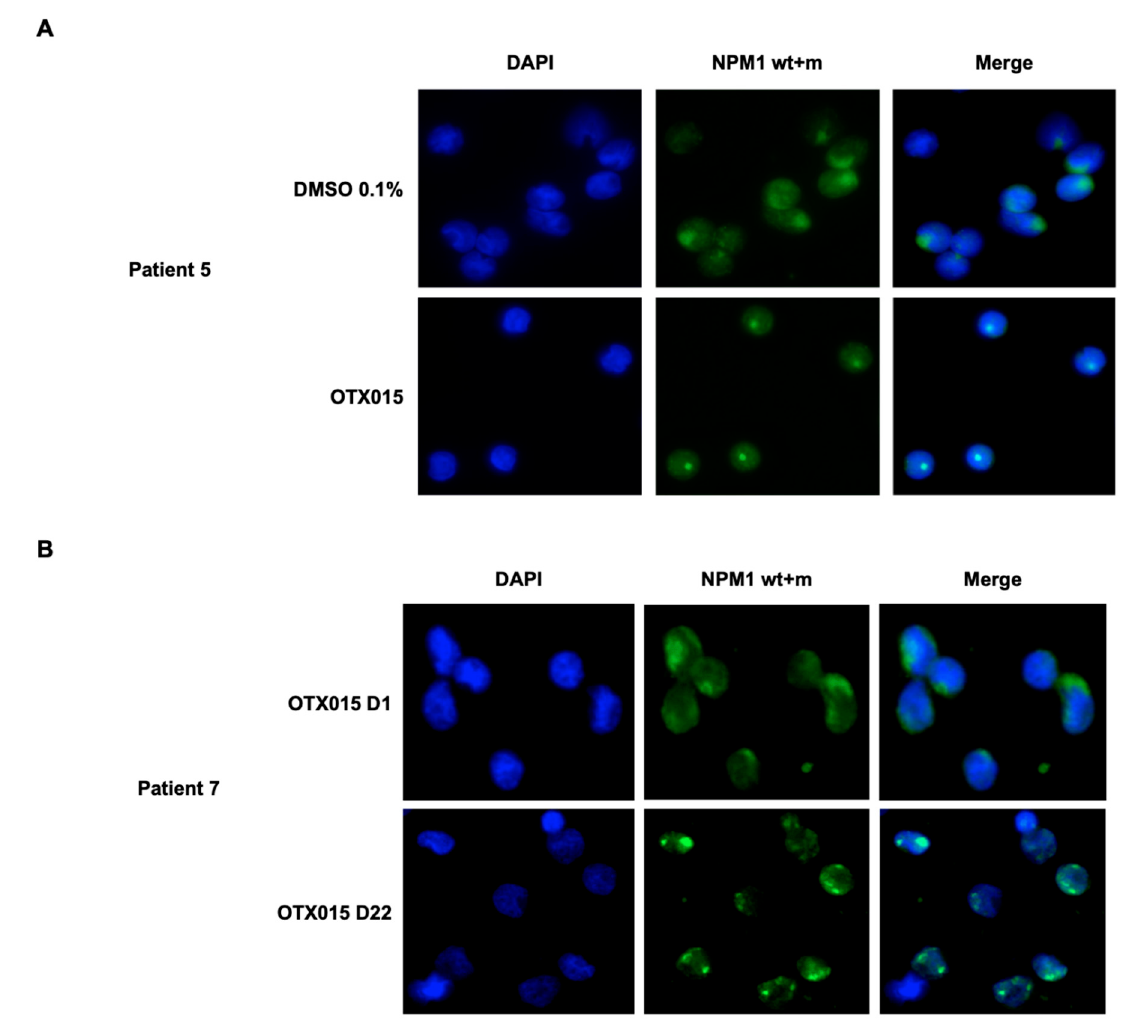
Figure 6. Ex vivo and in vivo treatment of patient-derived NPM1c bone marrow blast cells with OTX015 (MK-8628)-induced disappearance of NPM1c in the cytosol. Primary leukemic bone marrow blast cells were obtained from three NPM1c + AML patients. ( A ) For two patients blast cells were exposed ex vivo for 48 h to 0.1% DMSO or 500 nM OTX015 (MK-8628). One representative patient is shown. ( B ) For a patient treated in the phase I study in vivo by OTX015 (MK-8628) 120 mg once daily, bone marrow blasts were obtained on day 1 (80% BM blasts) and day 22 (60% BM blasts). Cells were analyzed by confocal immunofluorescence microscopy for cellular localization of NPM1 (wt + c). Cells were stained with an antibody-recognizing NPM1 (wt + c) (green) and nuclei are labeled blue by DAPI.